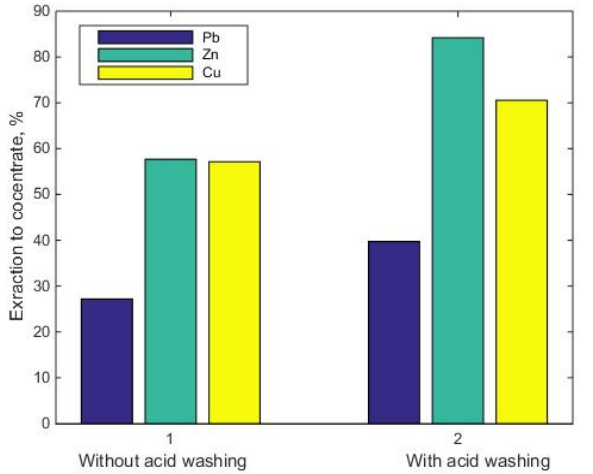
Figure 3. Comparison of the flotation results with pre-washing in an acid environment and without.